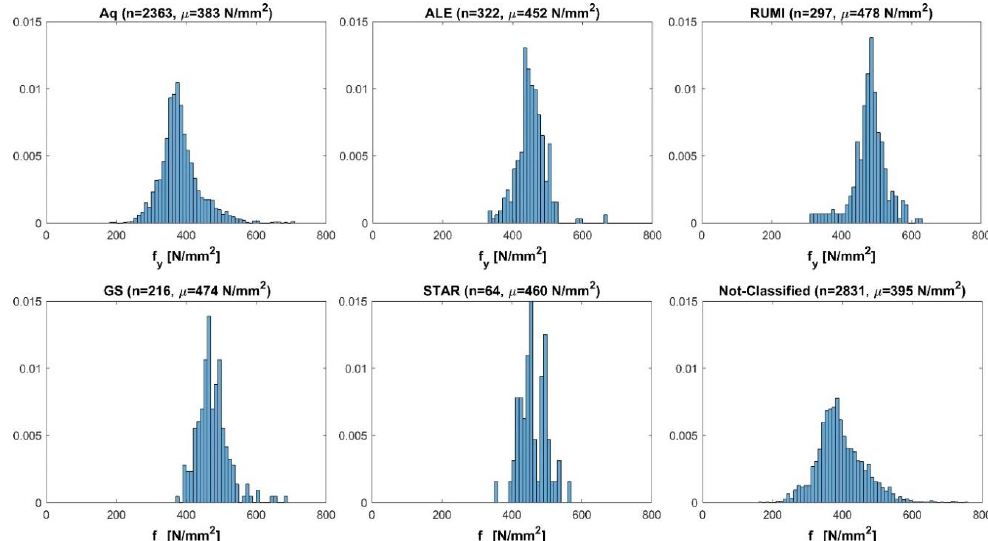
Figure 3. Histogram of yielding strength of main steel rebars used in Italy in 1960s: Aq , high elastic limit steel (known in Italy as ALE), RUMI, GS, STAR and not classified.